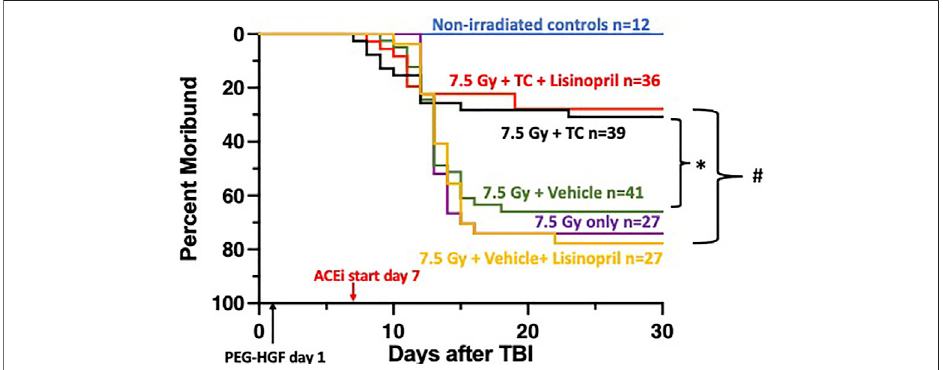
FIGURE 2 | Mitigation of hematopoietic-acute radiation syndrome (H-ARS) by triple combination with and without lisinopril. Kaplan-Meier plots show morbidity through 30-days after 7.5 Gy total body irradiation (TBI). The triple combination (TC, consisting of PEG-hG-CSF, PEG mGM-CSF and PEG hIL-11) or vehicle were given subcutaneously 24-h after TBI (designated by PEG-HGF) and the ACE inhibitor, lisinopril, was started in the drinking water 7 days after irradiation.